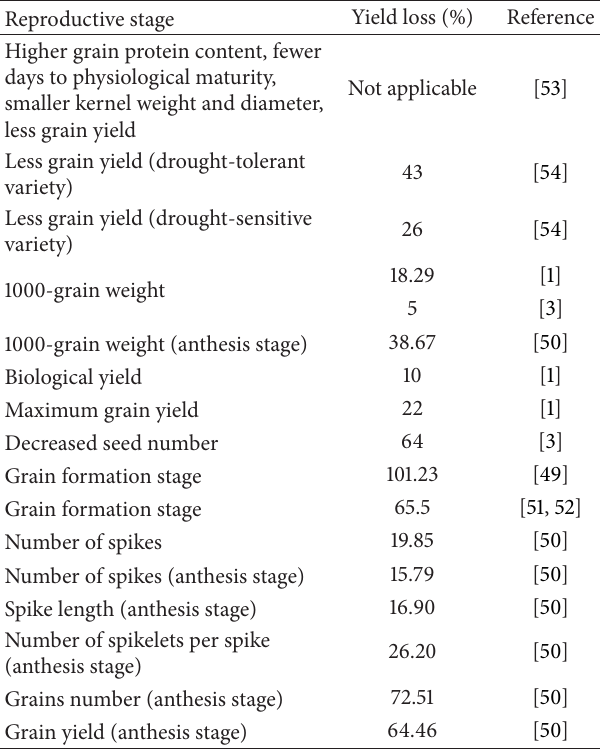
Table 2: Yield losses at reproductive growth stages under drought in